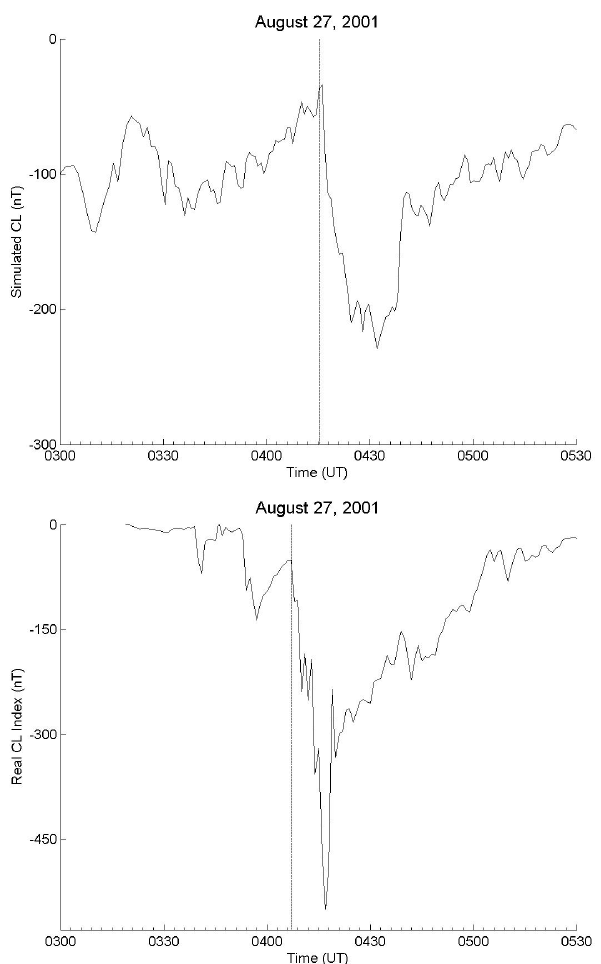
Fig. 8. Substorm expansion phase onset (vertical line) on 27 Au- gust. The real CL index is in the bottom panel and the simulation index is in the top